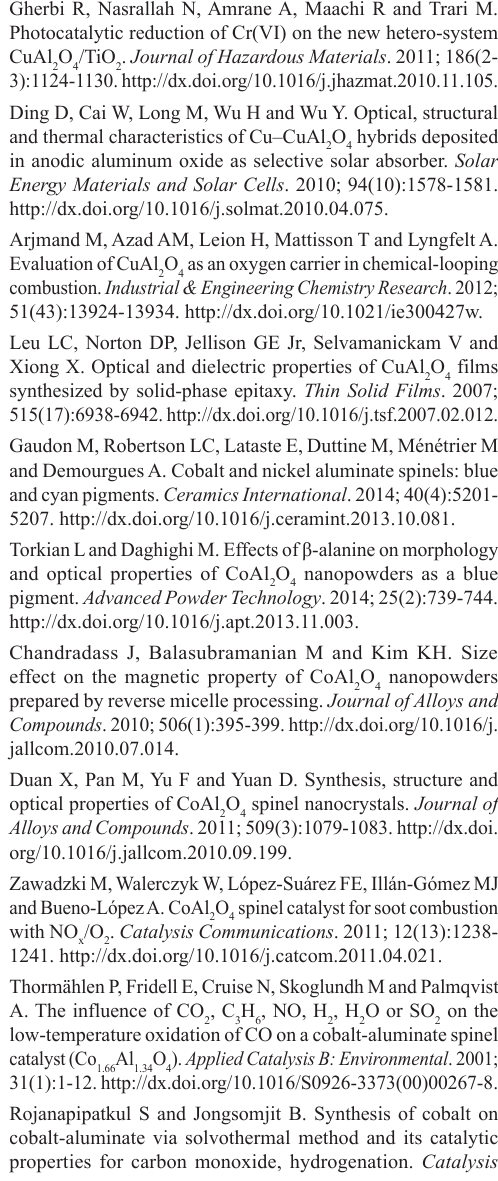
) of different supports T